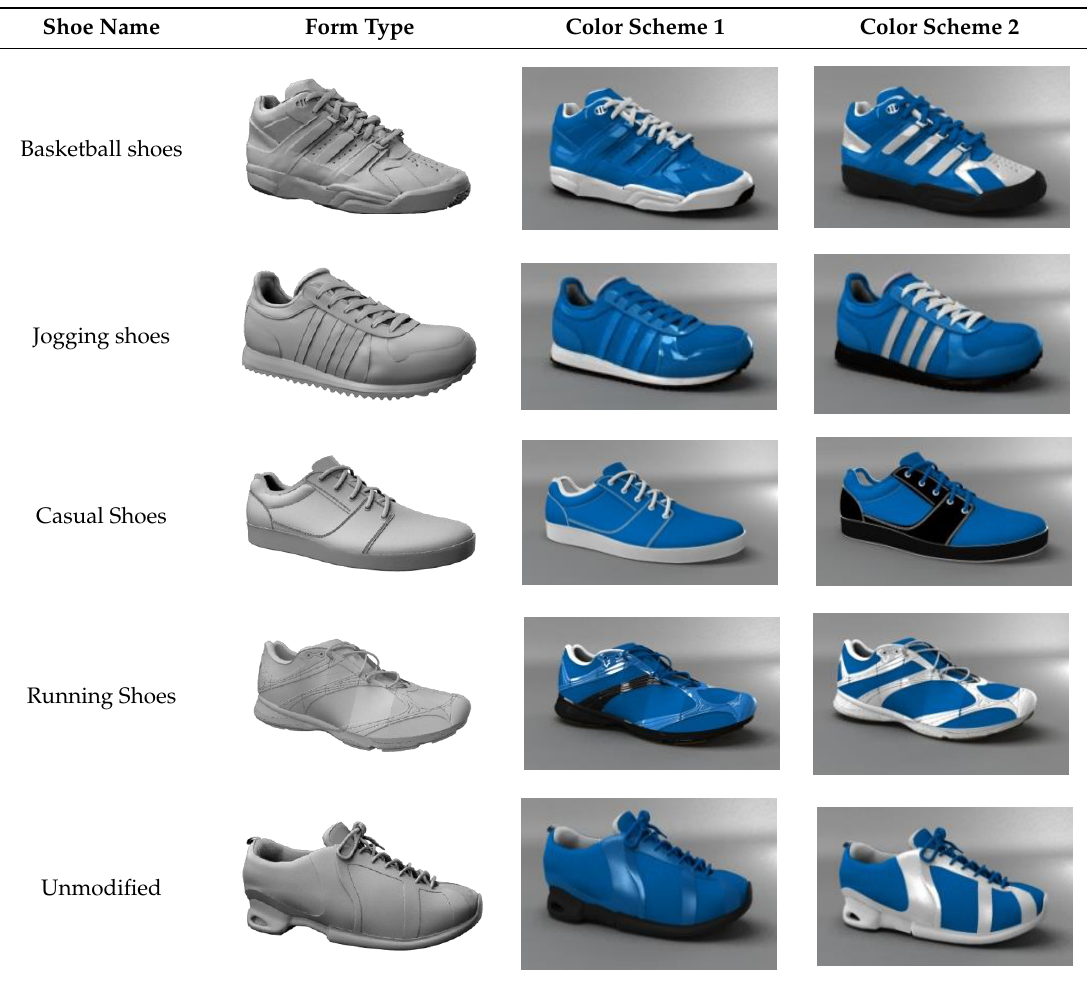
Table 1. Color schemes of the experimental designs.